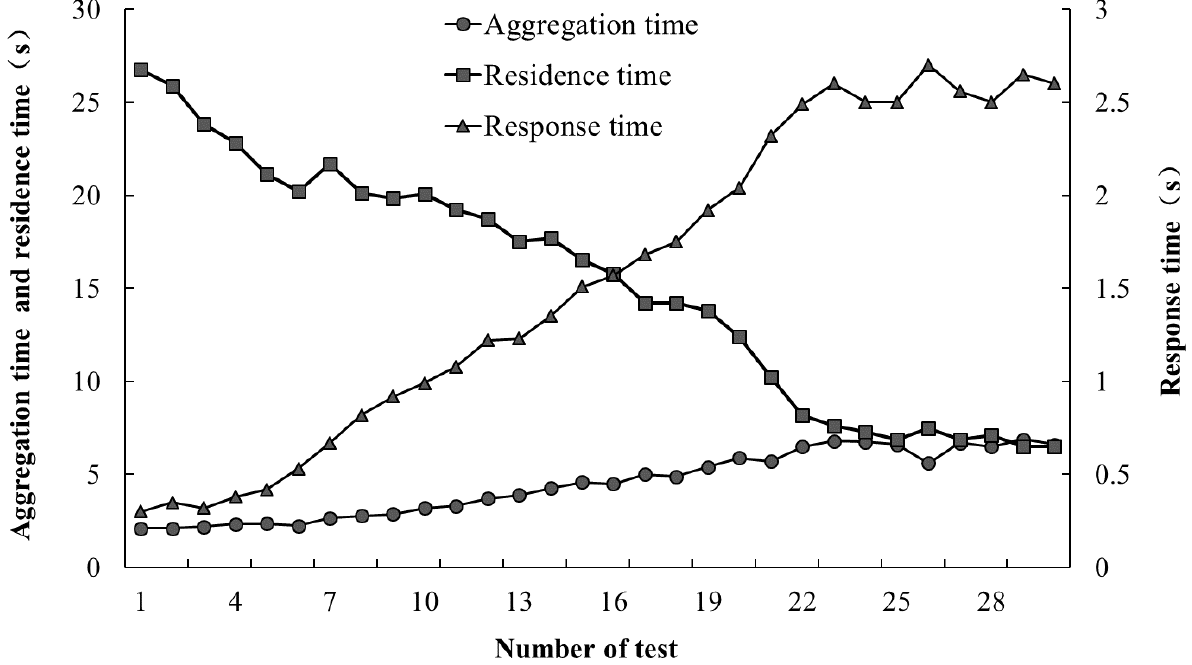
Figure 10. Changes in the response time, aggregation time, and residence time of juvenile Pagrus major after the elimination of the conditioned reflex test.